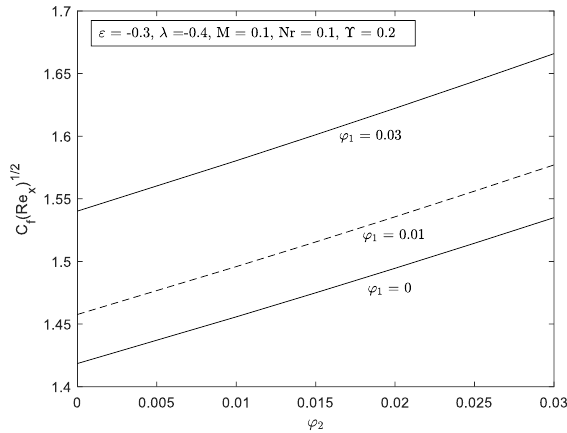
1 𝟏 𝟏 𝟏 2 for several ϕ 1 with ϕ 2 . Figure 14. 𝐶 𝟐 for several 𝜑 1 with 𝜑 2 . 𝟐 for several 𝜑 1 with 𝜑 2 . 𝒇 (𝑅𝑒 𝒙 ) 𝟐 for several 𝜑 1 with 𝜑 2 .